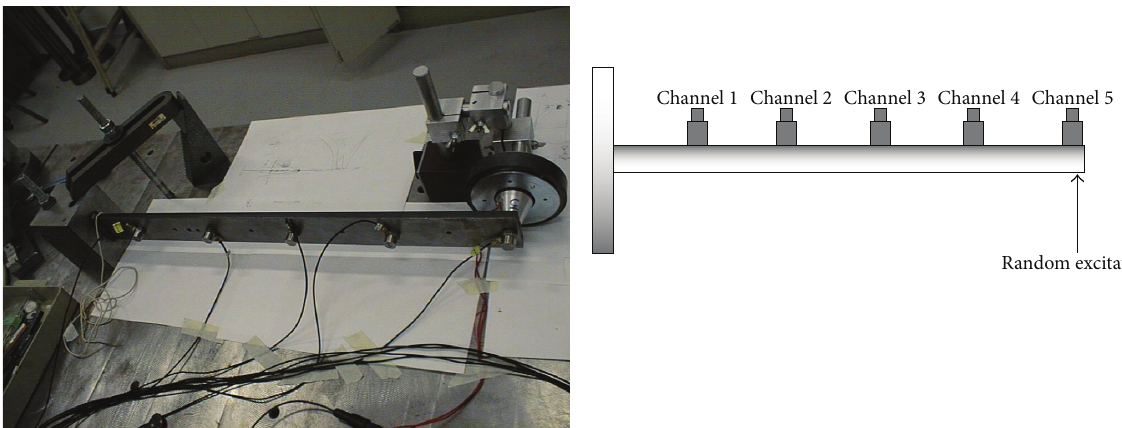
Figure 5: Schematic of the clamped beam in laboratory.